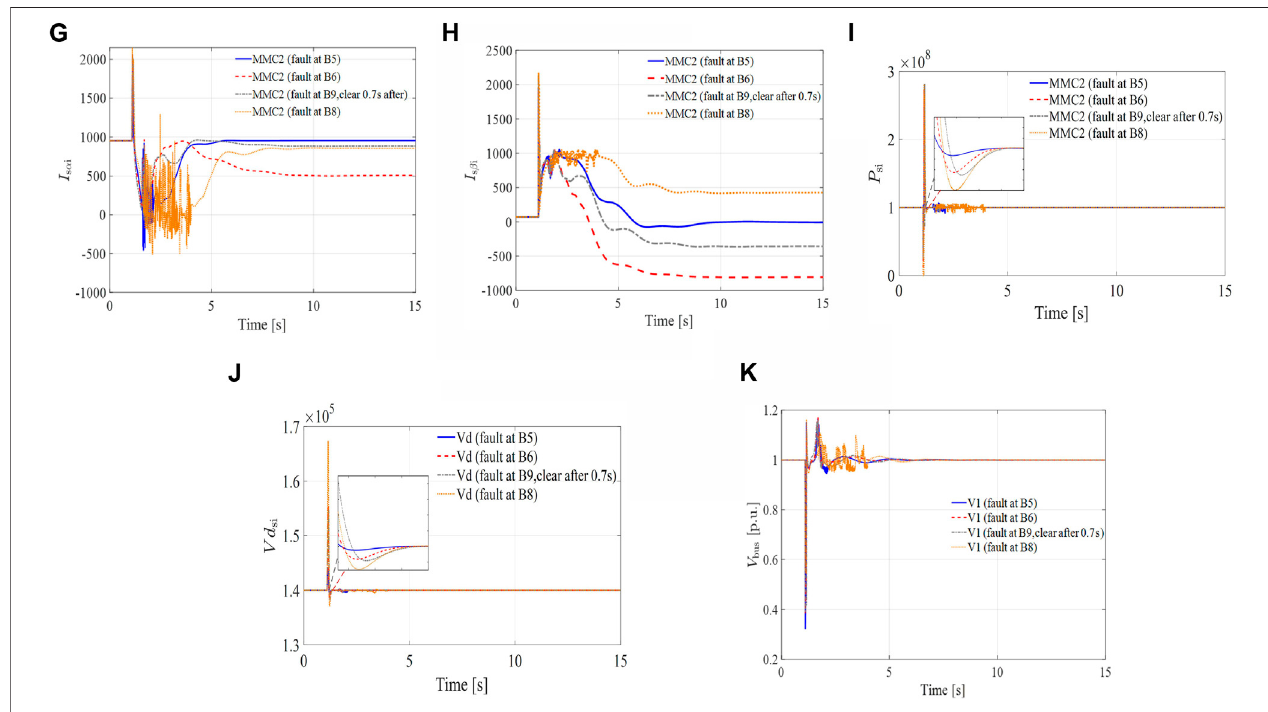
Frontiers in Energy Research |